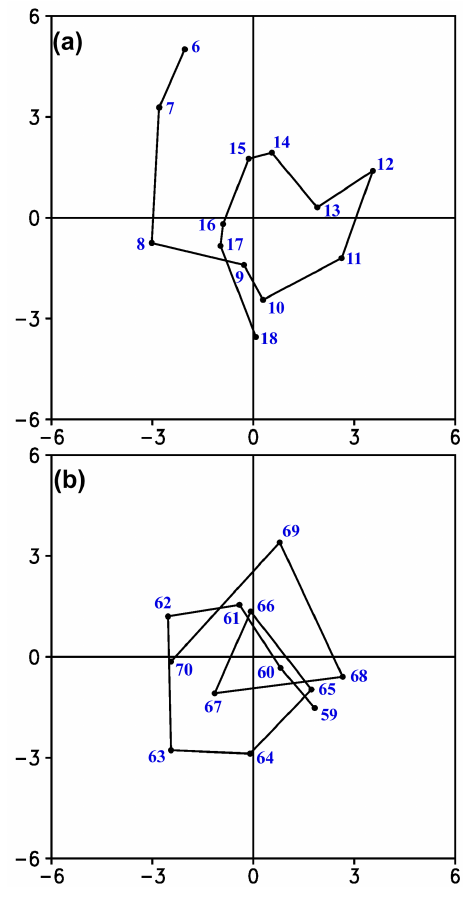
Figure 12. Small-amplitude oscillation of the tropical cyclone track with respect to the 9h running mean track: (a) 6–18 and (b) 59– 69h. The x and y axes indicate the distance (km) relative to the 9h running mean